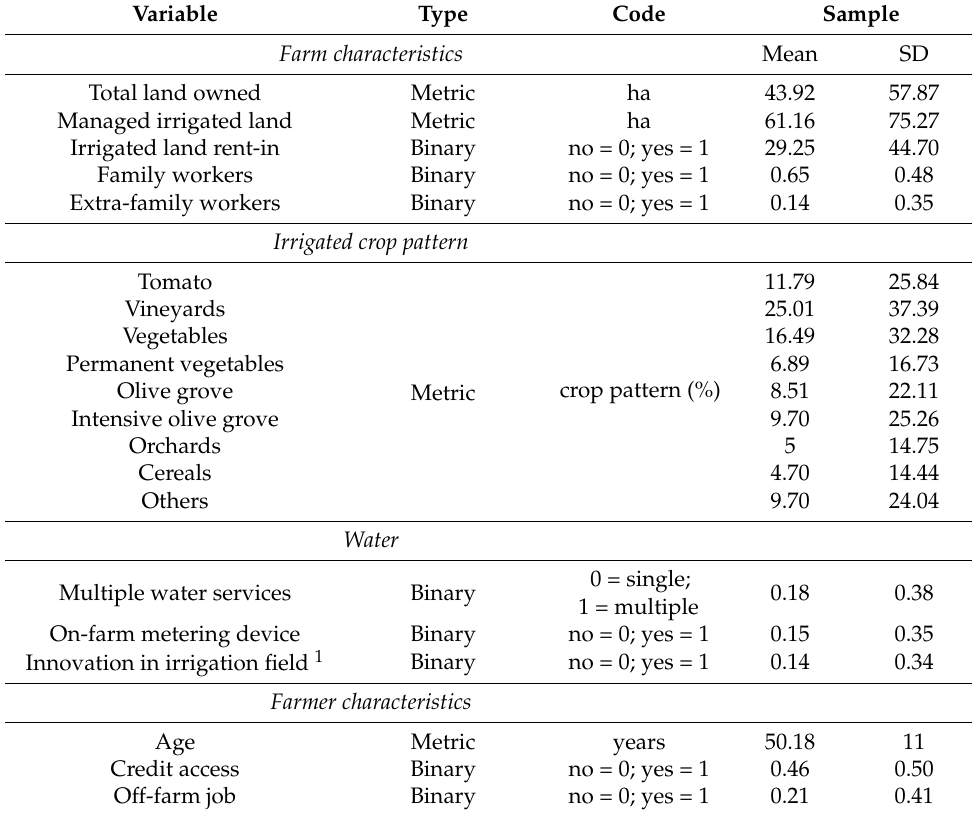
Table 1. Variables used as determinants in cluster